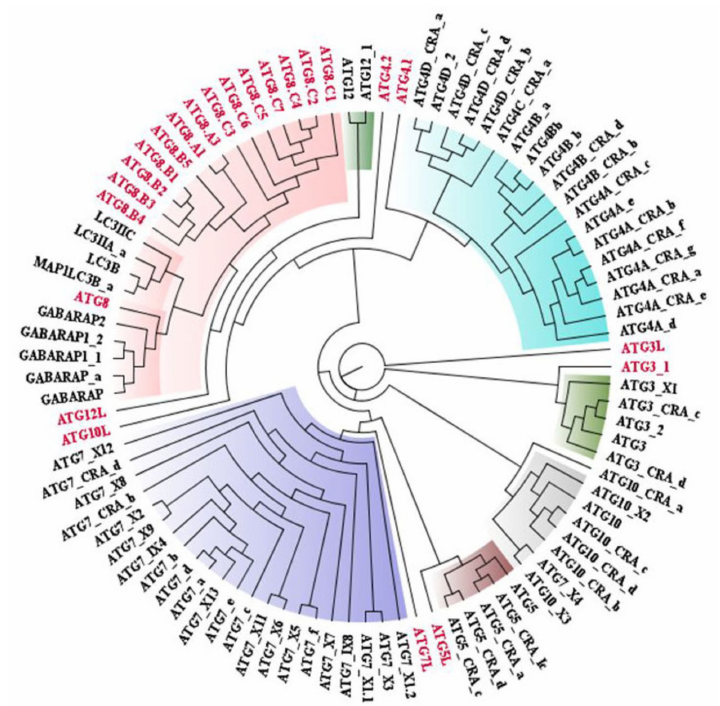
Figure 2. Phylogenetic tree showing similarity between ATG proteins among Homo sapiens and Leish-